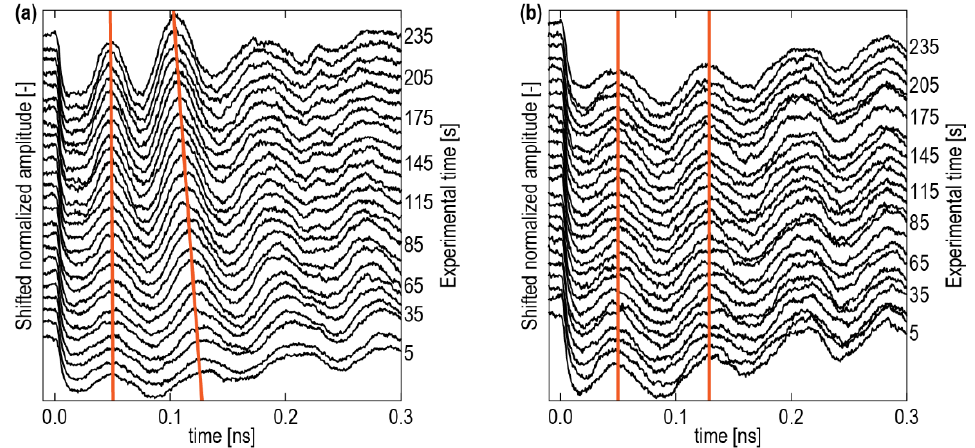
Figure 4. Vertically shifted normalized transient optical reflectivity signals ∆ R / R recorded in the films ( a ) 1 hN and ( b ) 1 hA with a 26 mW pump power and a 1 mW probe power at different time points (right vertical axis) from the beginning of the TDBS experiment. Experimental time increases from the bottom to the top of each figure. The time interval along the horizontal axis between the two orange lines, passing the neighbor maxima of the Brillouin oscillations, provides an estimate of their period, i.e., the inverse of the Brillouin frequency (BF) in Equation (2). The revealed variation of the BF with experimental time in ( a ) is a signature of an additional curing of low-k films by laser light.